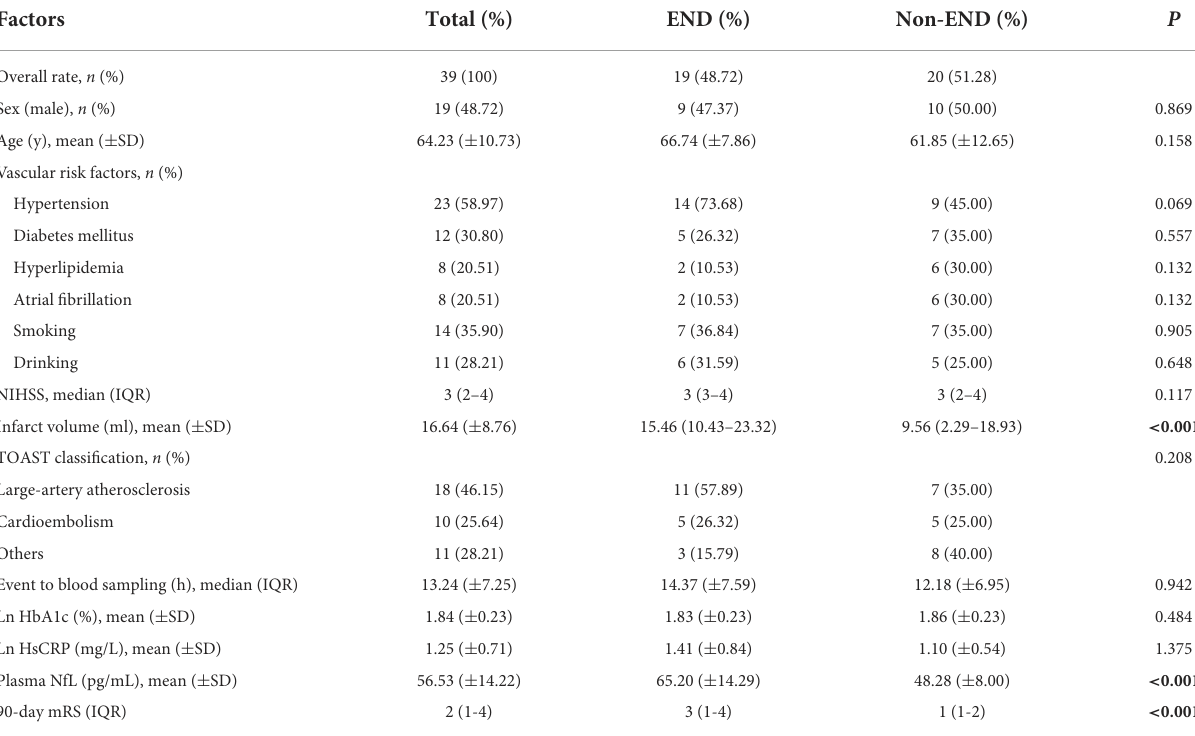
TABLE 1 Demographic and clinical characteristics of the patients.